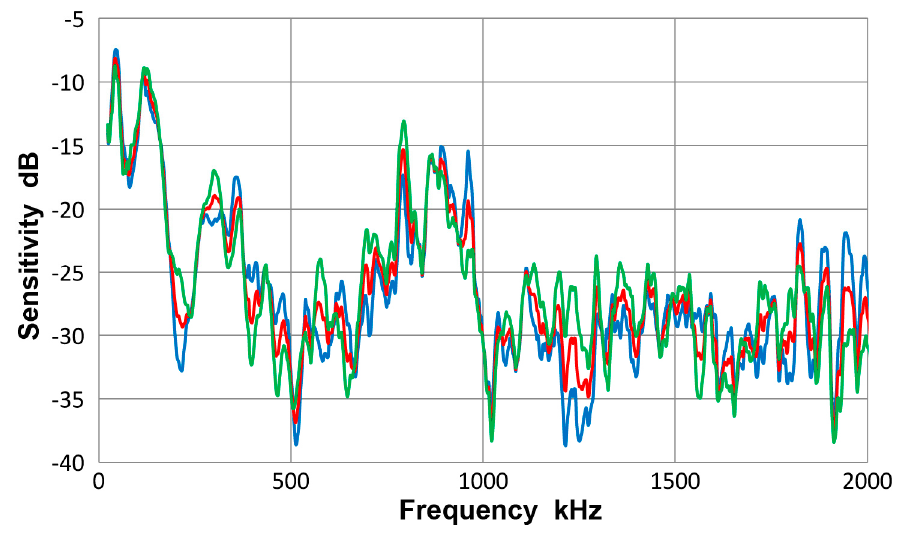
Figure A7. Receiving sensitivity of PAC S9220 sensor. Red -averaged guided wave sensitivity, blue -Lamb waves for 12.7 and 6.4 mm plates, green -bar waves for 12.7 and 6.4 mm bars.